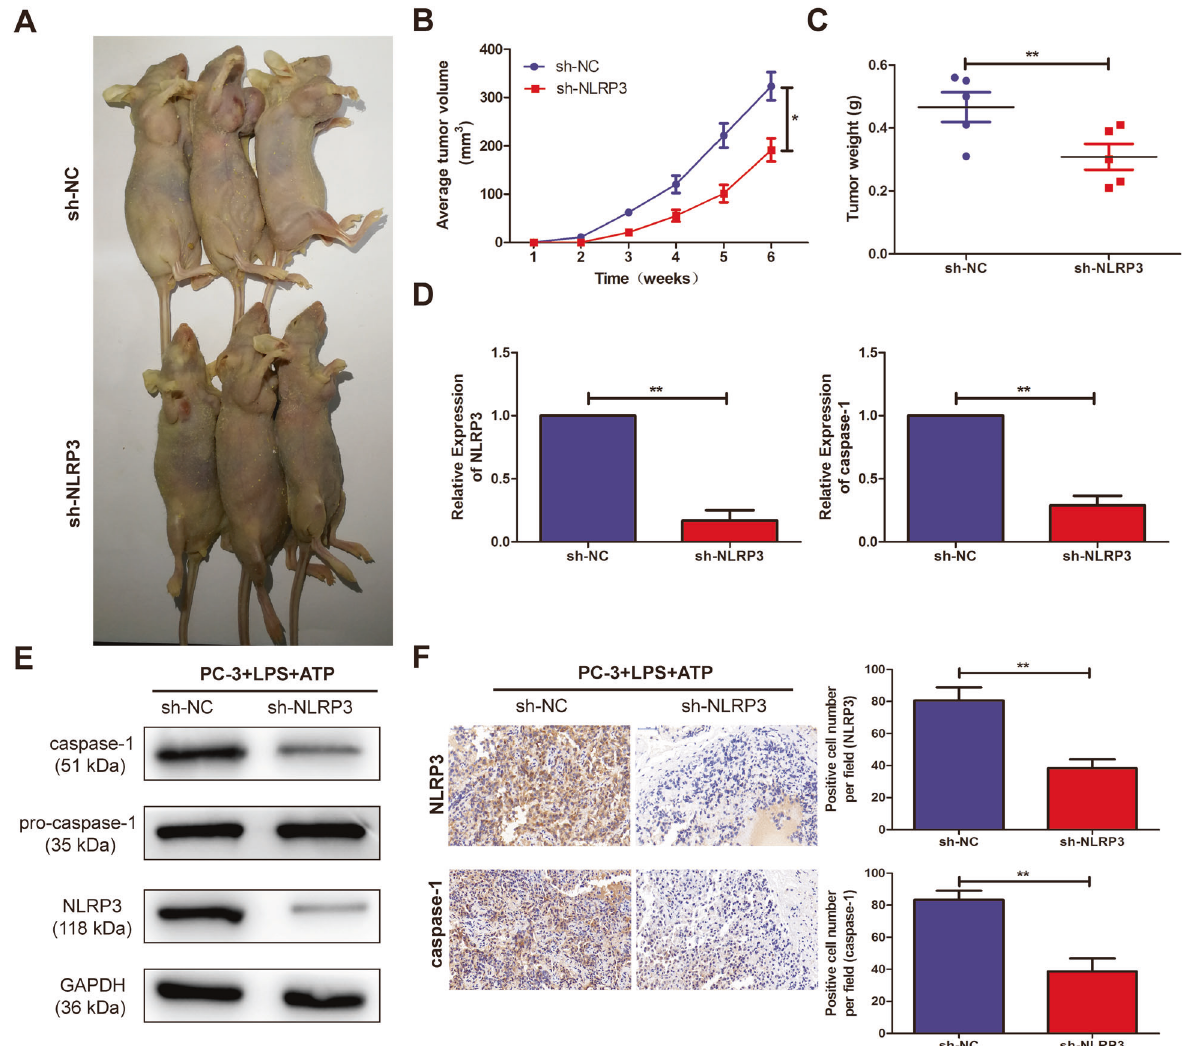
Fig. 5 Knockout of NLRP3 inhibited tumorigenic ability in nude mice. A Representative pictures of tumor in sh-NC and sh-NLRP3 cell- transplanted mice in PC3 cell line. B Tumor volume growth curves were calculated for different nude mice after injection of sh-NC and sh- NLRP3, respectively. C Tumor weight growth curves were calculated after injection of sh-NC and sh-NLRP3, respectively. D qRT-PCR assay was used to detect the expression level of NLRP3 and caspase-1 in the tumor-forming tissues of nude mice. E Western blot was used to detect the expression level of NLRP3 and caspase-1 in the tumor-forming tissues of nude mice. F Immunohistochemistry was used to detect the expression level of NLRP3 and caspase-1 in the tumor-forming tissues of nude mice with PC3 cells (magni fi cation: ×40). Data are mean ± SD, * p < 0.05, ** p <